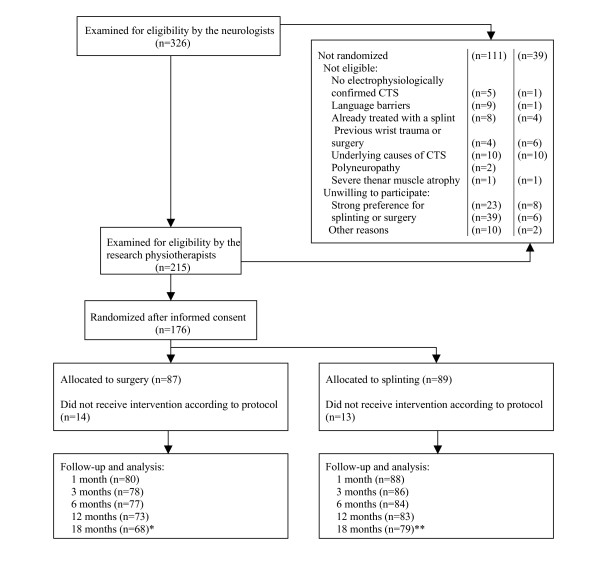
Progress of patients through Carpal Tunnel Syndrome (CTS) trial. * Reasons for withdrawal from the study (n = 19): refused to undergo surgery (n = 8); private matters (n = 2); lack of time (n = 1); died of cancer (n = 1); unable to attend the hospital at 12 months (n = 2); did not return the final questionnaire (n = 5). ** Reasons for withdrawal from the study (n = 10): lack of time (n = 3); private matters (n = 1); not satisfied with treatment result (n = 1); unable to attend the hospital at 12 months (n = 1); did not return the final questionnaire (n = 4).